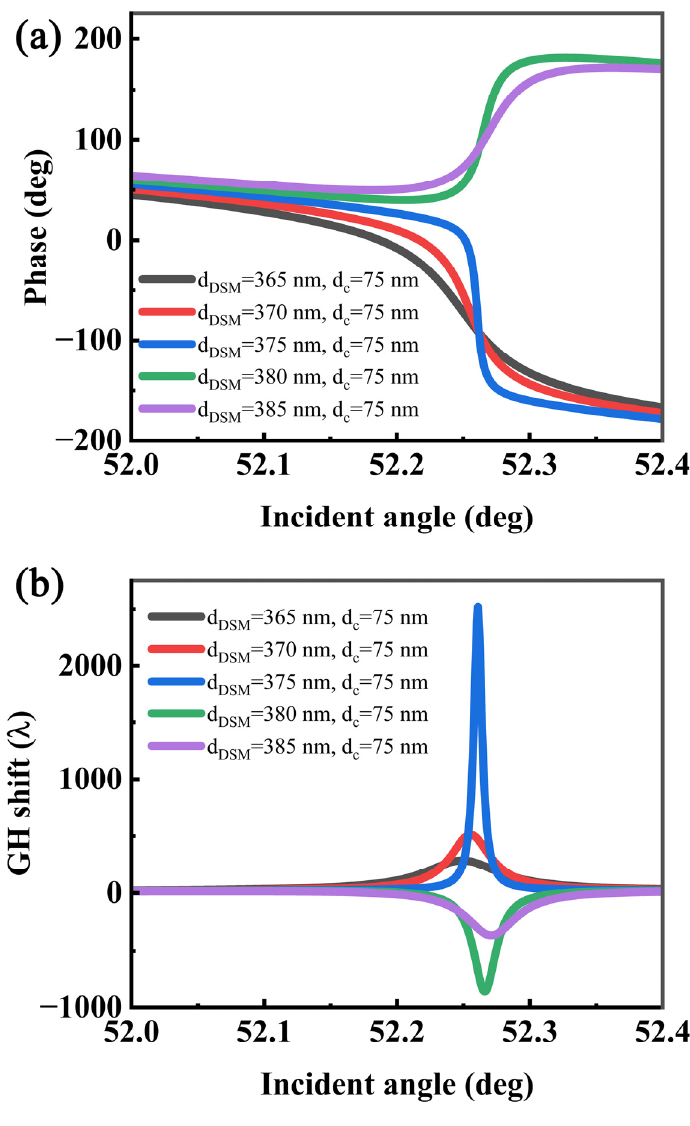
Figure 7. Relationship between the ( a ) phase, ( b ) GH shift, and angle with different DSM thick-